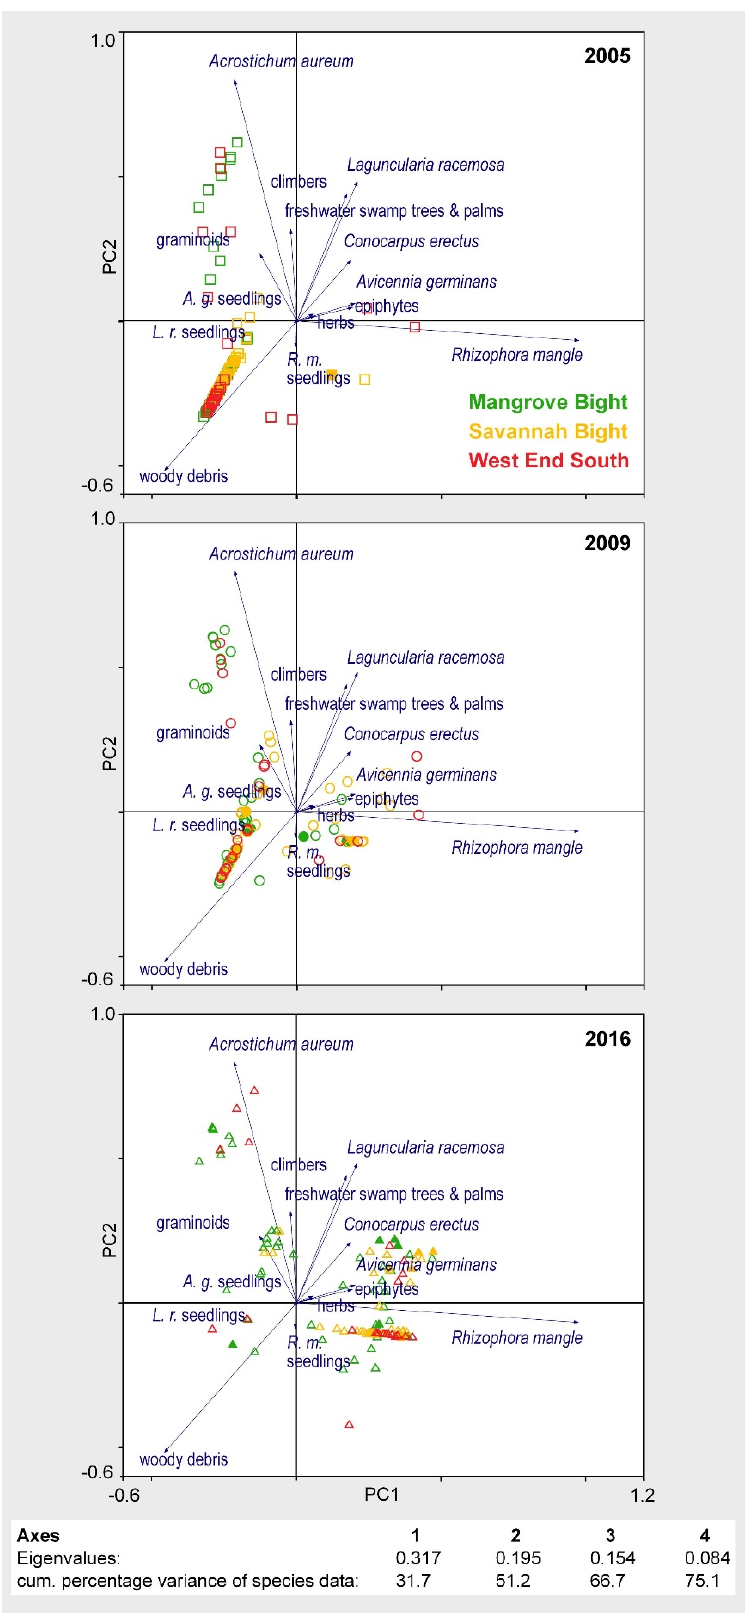
Figure 6. PCA scatterplot encompassing all 10m-transect segments of all sampling dates (2005, 2009, 2016) for MB, SB, and WES; for sake of clarity, data are presented separately for the different sampling dates (adapted and modified from [37]).